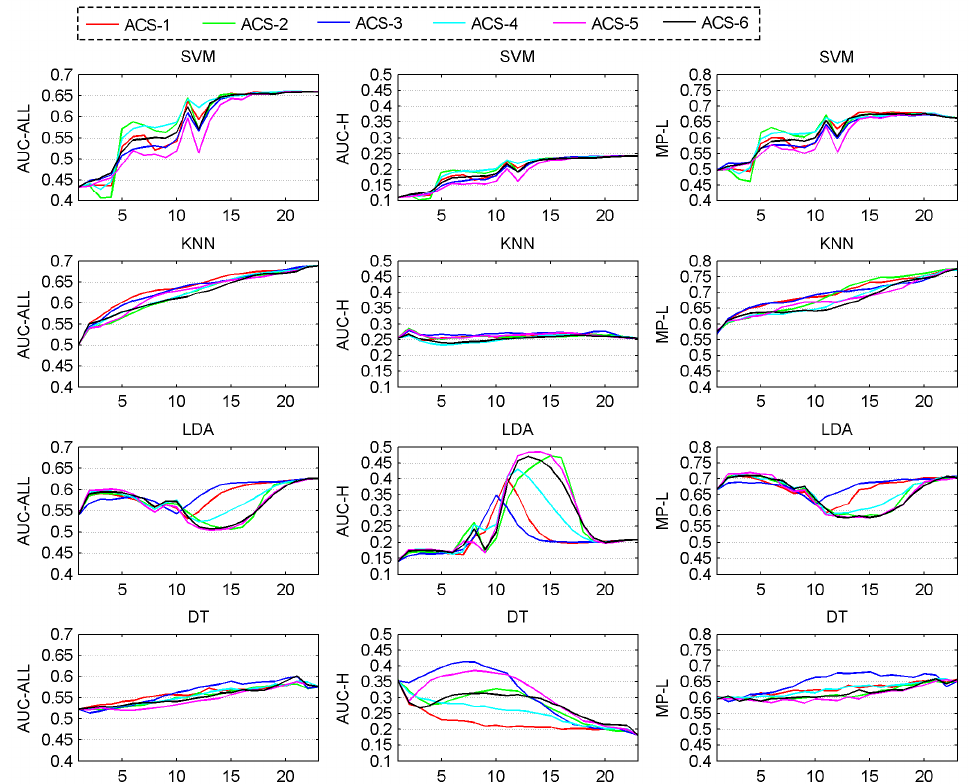
Figure 8. Graphs of performance evolving over iterations (horizontal axis) for ACS methods coupled with SVM, KNN, LDA and DT classifier (RRAS are used here). AUC-ALL, AUC-H and MP-L are the measures of overall performance, high-TPR performance and sorting performance, respectively.